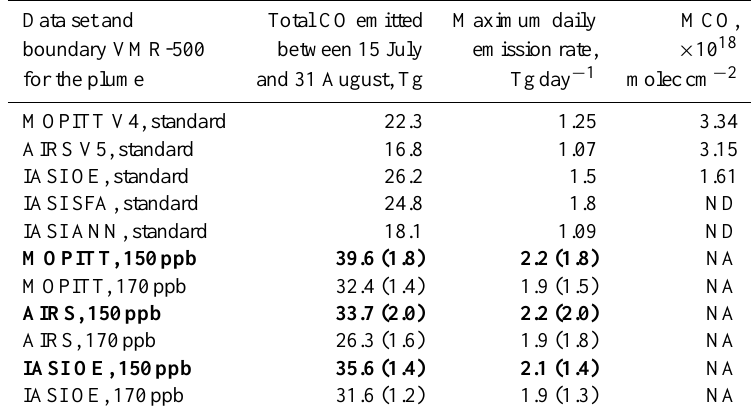
Table 3. CO emission rates derived from the data of space sounders using mass balance box modeling for the standard case (as is), and for the burdens corrected for MCO. Corrections for MCO were applied to the satellite data inside the plume; the boundaries of the plume were specified by 150ppb (main case that highlighted in bold) and 170ppb (supplementary case).